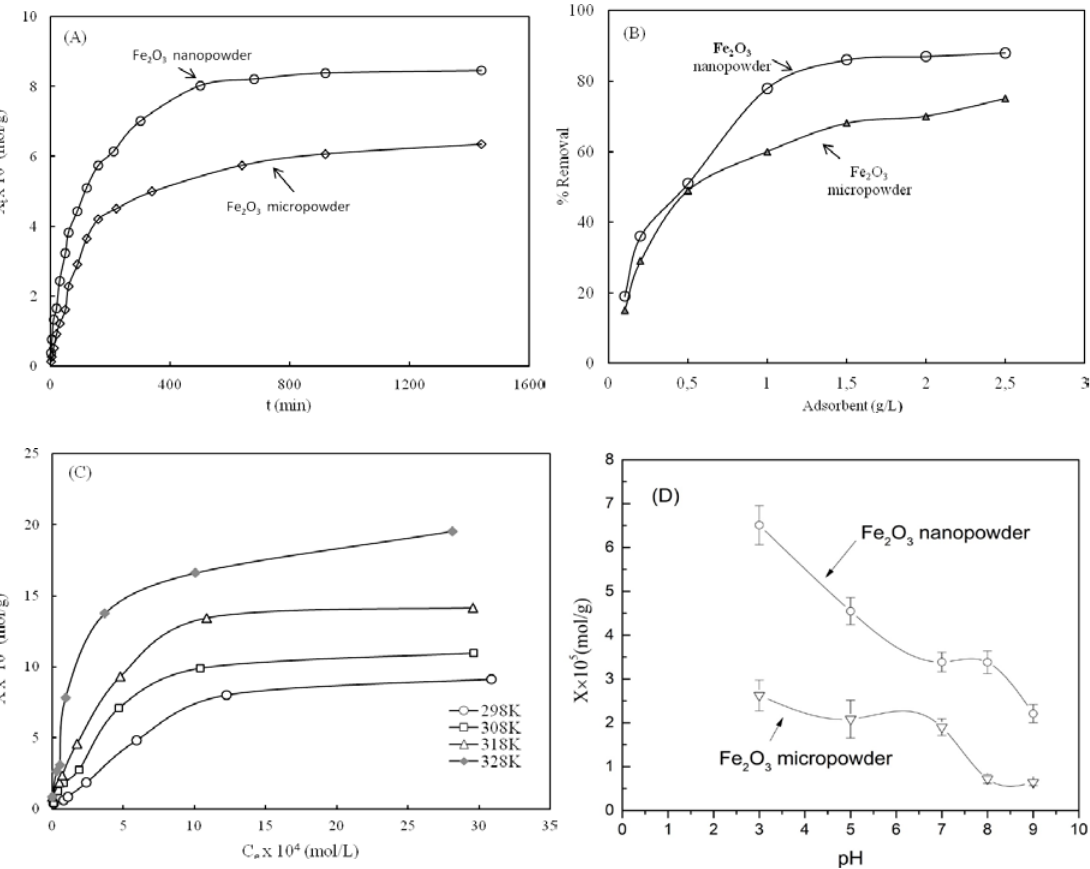
O micro- 2 3 O 2 3